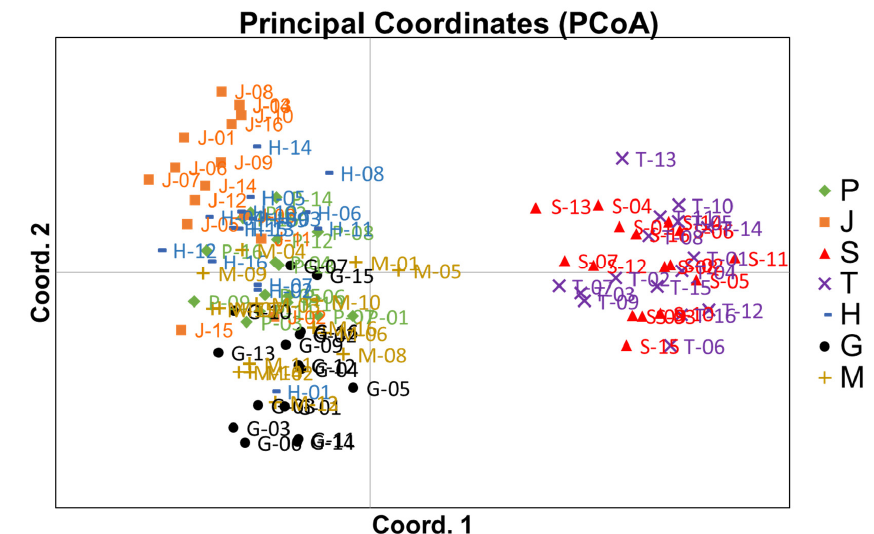
Figure 1. Principal coordinate analysis (PCoA) reveals associations between onion cultivars according to evolutionary relationships. P, J, S etc. are the cultivars name as defined in Table 1.